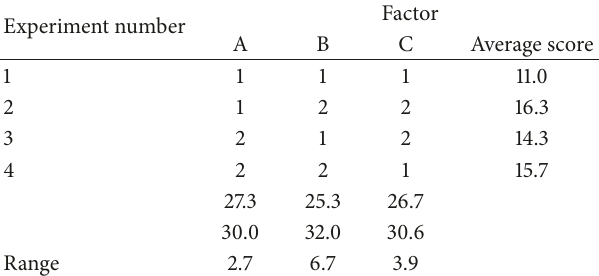
Table 3: Results of the pressured water coupling blasting